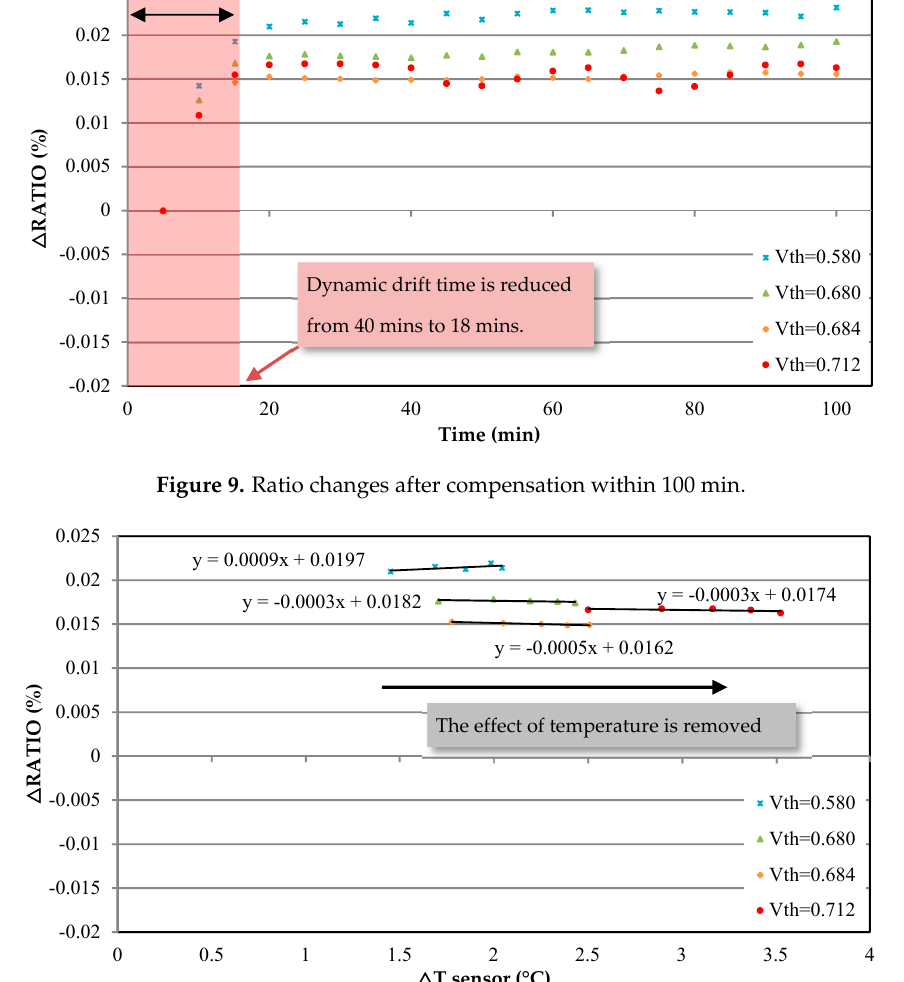
Figure 10. Relationship between Ratio and T sensor with temperature compensation.